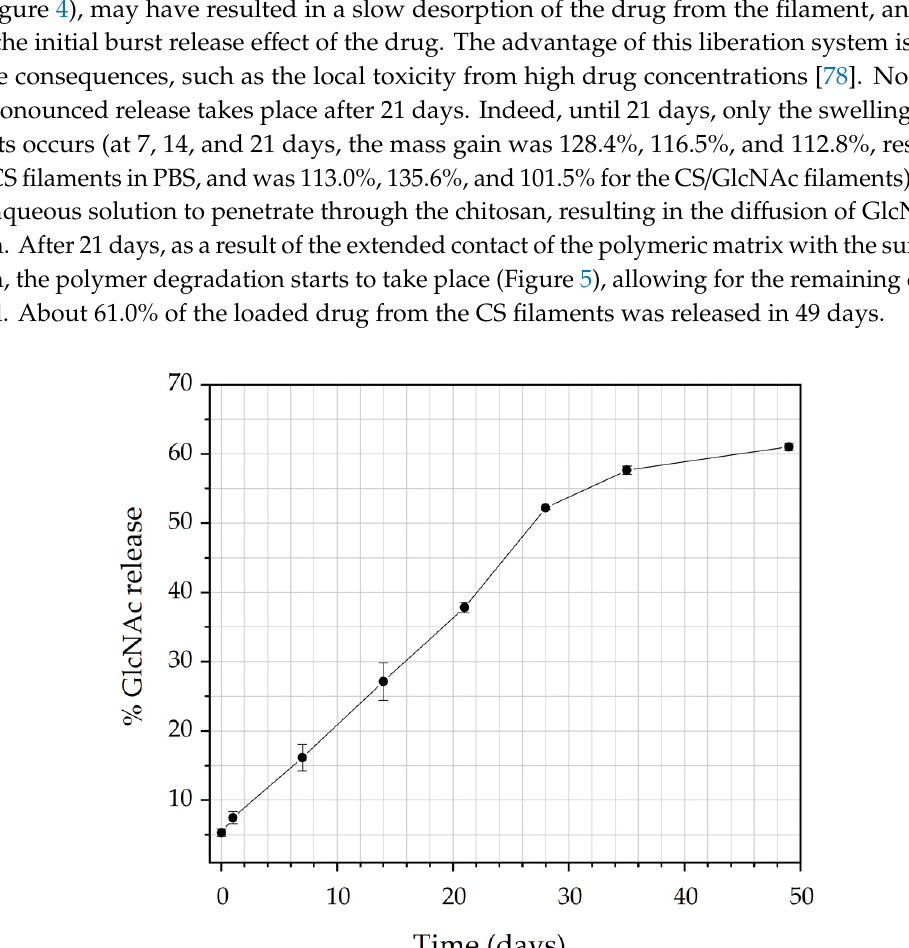
Figure 7. The cumulative release curve of GlcNAc from CS filaments in a pH 7.4 buffer at 37 ° C.